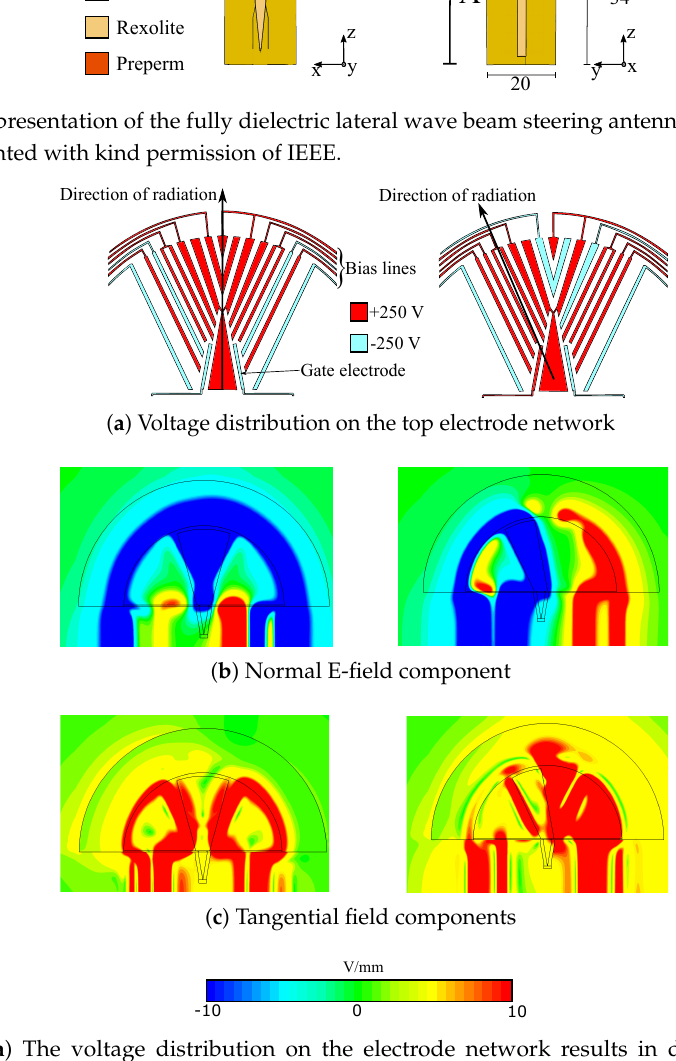
Figure 47. ( a ) The voltage distribution on the electrode network results in different bias field distributions in the LC filled cavity, leading to components responsible for high permittivity ( b ) and low permittivity ( c ). The desired sector of high permittivity is included in ( b , c ). [47], reprinted with kind permission of